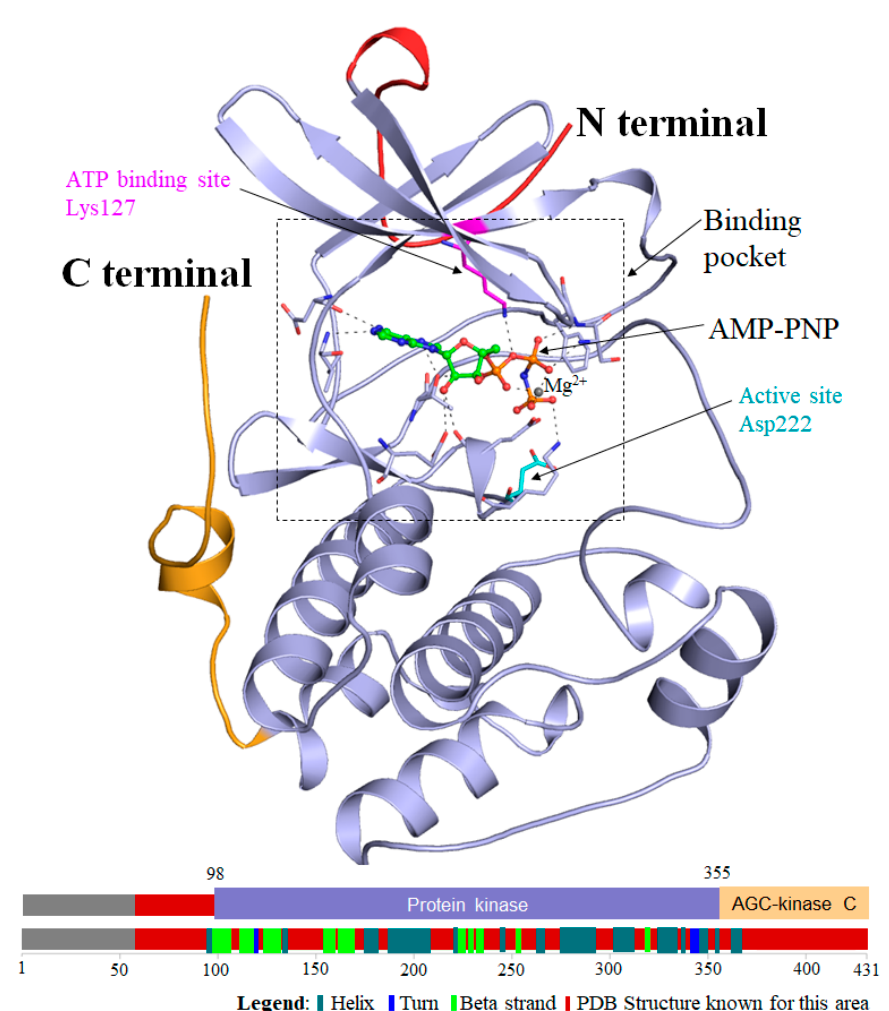
Figure 1. Structural organization of serum and glucocorticoid-regulated kinase 1 (SGK1). The overall structure of the SGK1 kinase domain in complex with co-crystallized AMP–PNP (adenosine 59(beta gamma-imido) triphosphate), and Mg 2+ . The N-terminal domain is in red, the C-terminal domain is in orange. AMP–PNP is shown in ball and stick model. Magnesium is represented by a grey sphere (upper). Schematic representation of the domain organization of SGK1 with secondary structural features (lower). The structure was drawn in PyMOL by using the atomic coordinates of SGK1 from the Protein Data Bank (PDB ID: 2R5T). The information about the domain organization was taken from UniProt (ID: O00141).